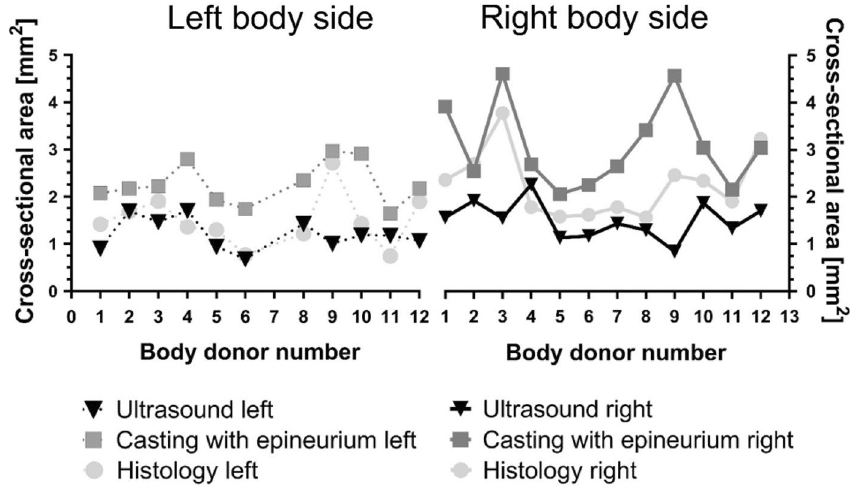
Figure 4. Determining the cervical vagus nerve cross-sectional area with ultrasound, cast, and histology. Interindividual differences donor- and side-depended were detected. Black—ultrasound darker grey—casting, lighter grey—histology. Dotted lines indicate the left and full lines the right body side.